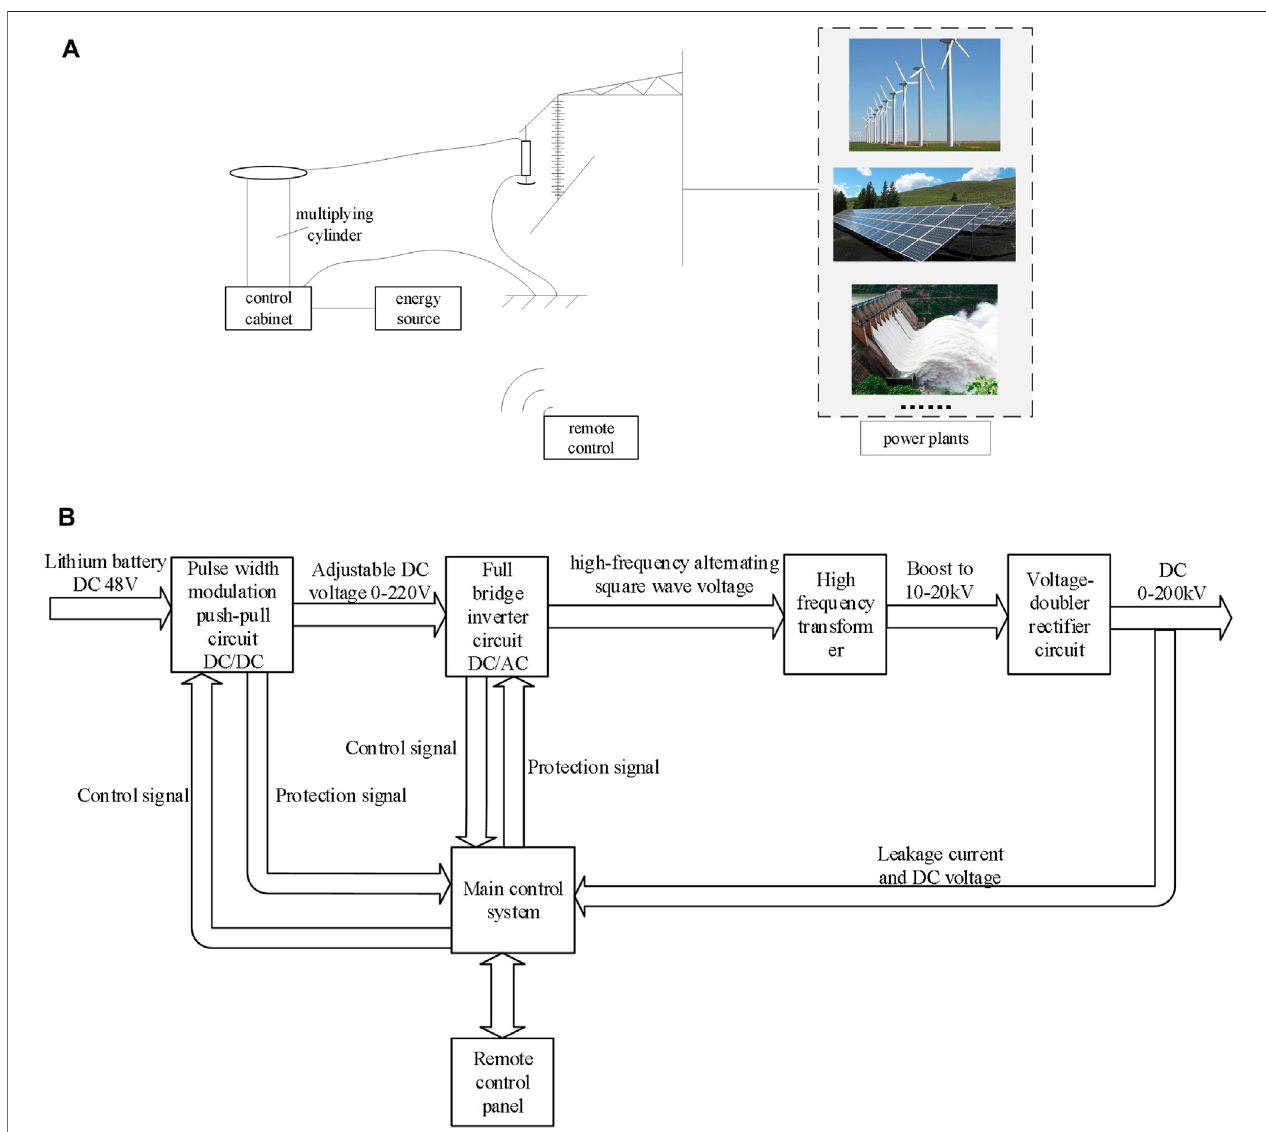
FIGURE 1 | Composition of DC test system. (A) Overall system framework; (B) Design block diagram of DC test system.